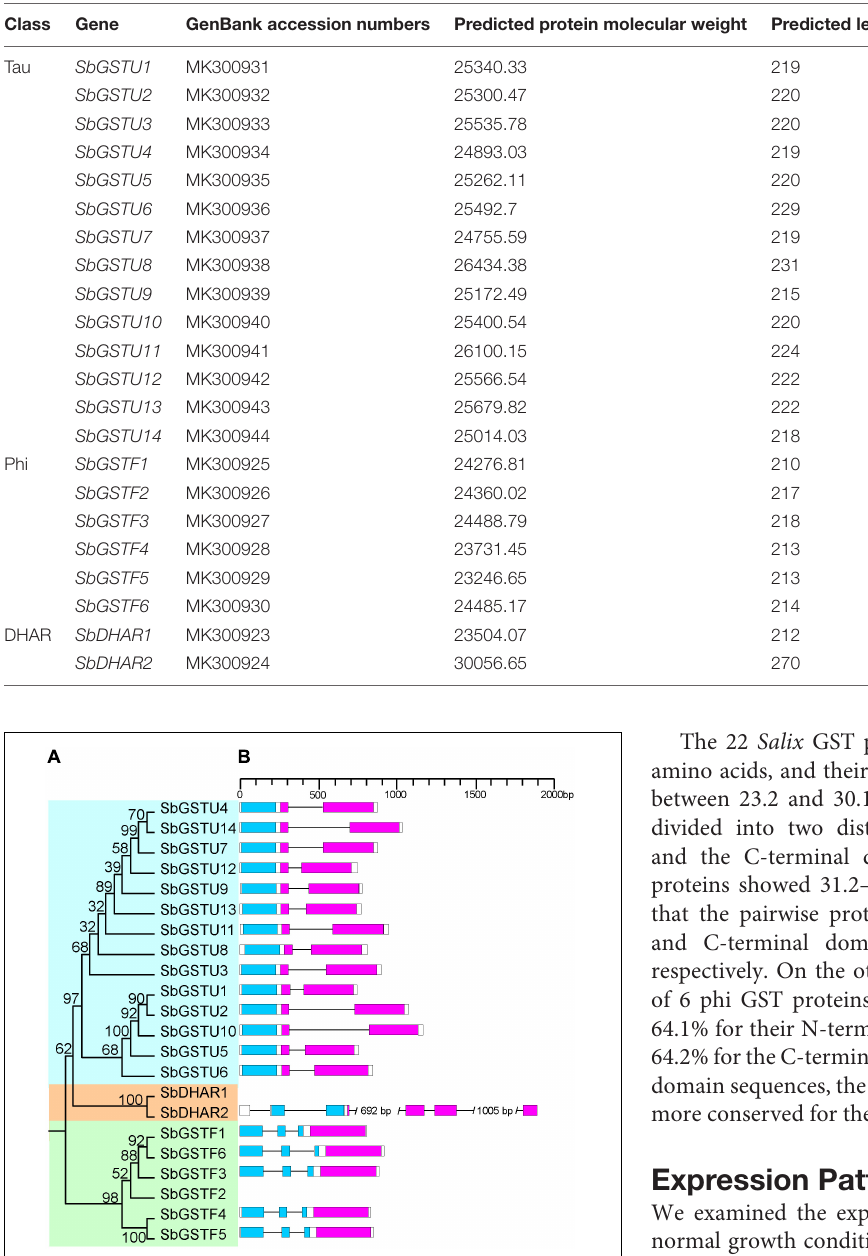
FIGURE 1 | Phylogenetic tree of Salix GSTs (A) and their gene structures (B). The tree was reconstructed with protein sequences using ML procedure with JTT model. Numbers at each node in the ML tree signify bootstrap values. Different GST classes are shaded with different colors. The GST N-terminal domain and C-terminal domain are highlighted in blue and purple, respectively. Introns are indicated as